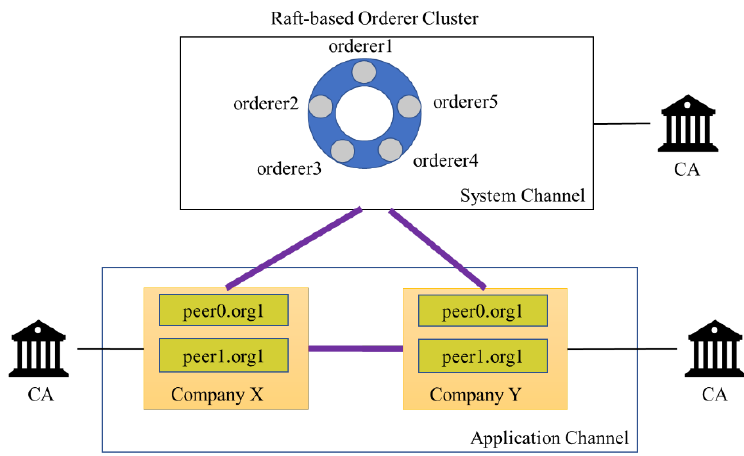
Figure 3. Multi-host deployment of Hyperledger Fabric network.